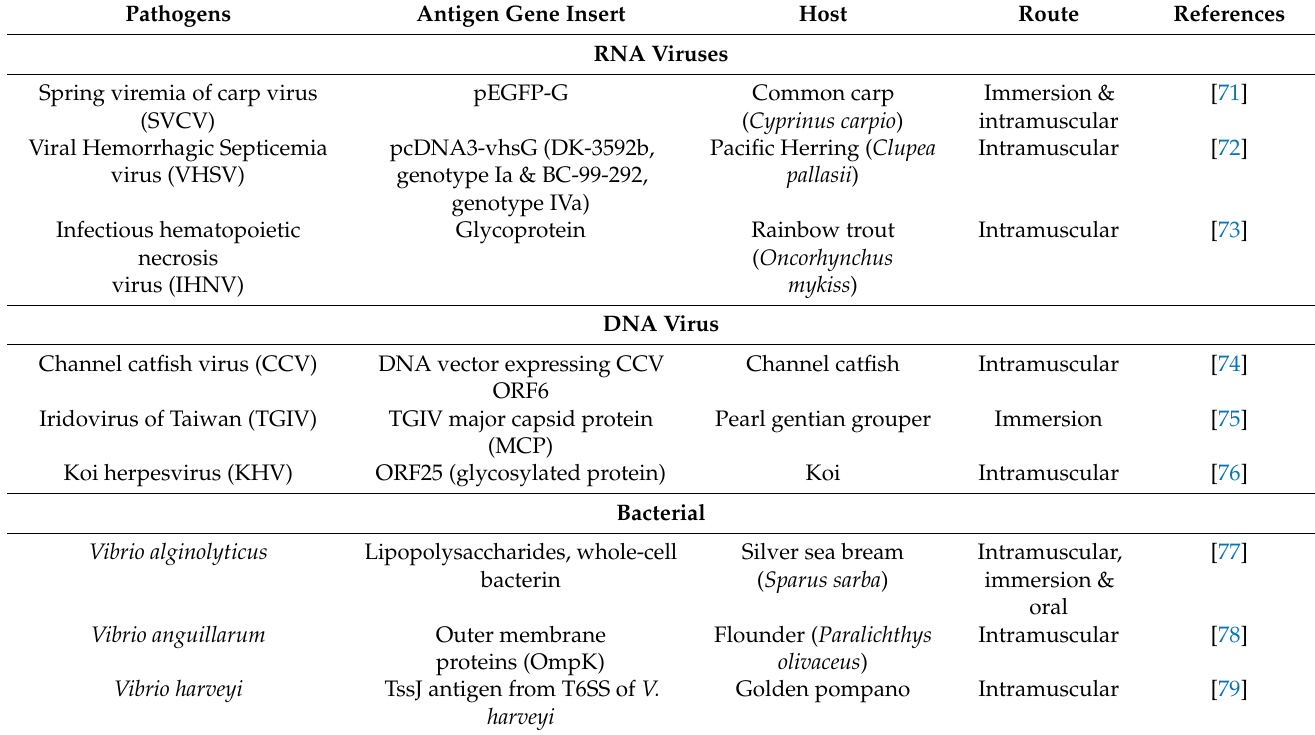
Table 1. Types of vaccines administered to